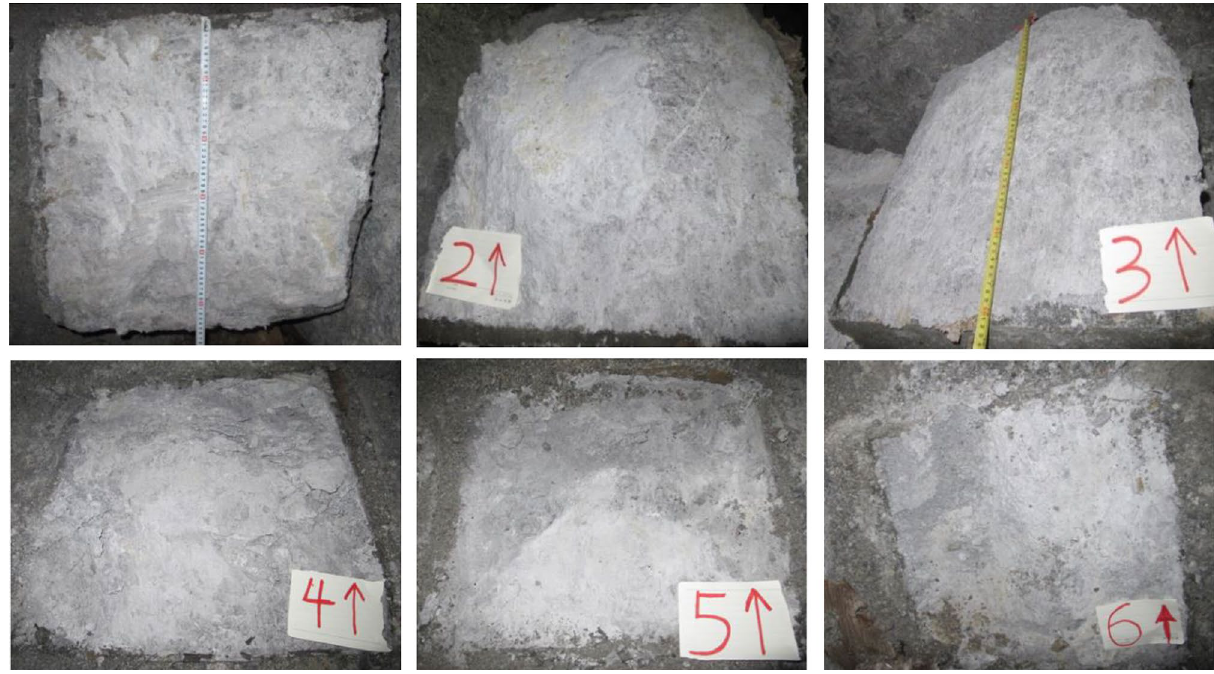
Figure 9. Pictures of surface after the first shear test.